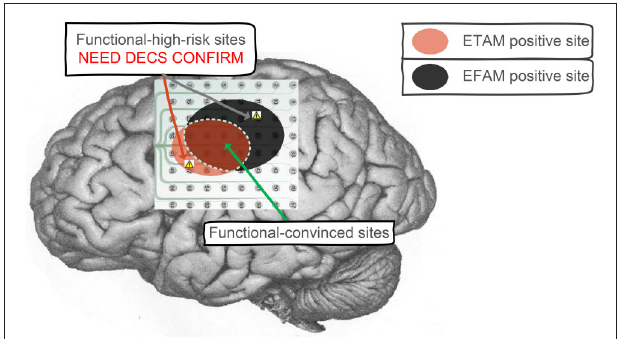
FIGURE 4 | Clinical application to combine ETAM and EFAM together. Both ETAM and EFAM positive electrodes were regarded as functional-convinced sites, electrodes with opposite results were regarded as functional-high-risk sites. The functional-convinced sites need to be protected, while additional DECS procedure need to be performed on the functional-high-risk sites for function